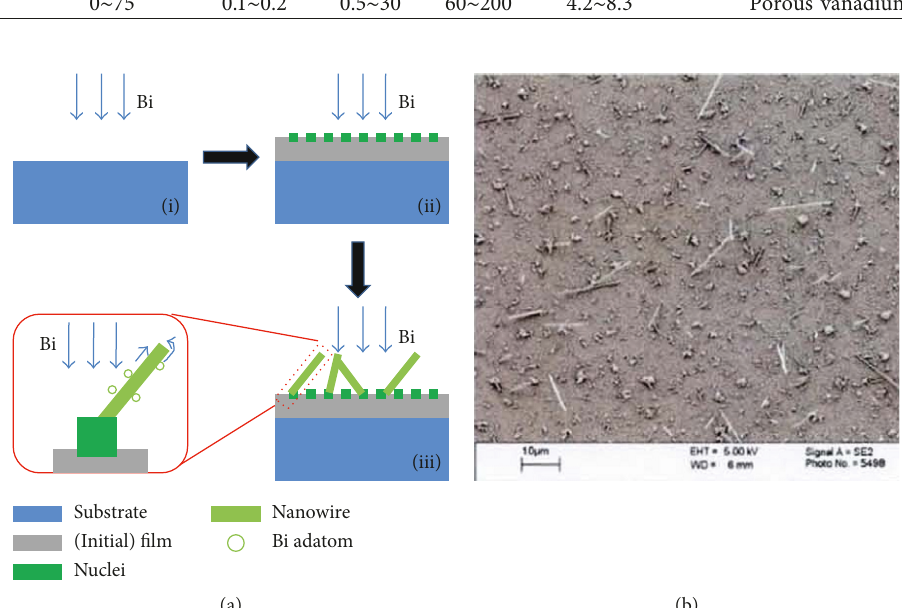
Figure 6: (a) Schematic representation of the tip-growth mode. (b) SEM image of Bi nanowires following the tip-growth mode. Reprinted from © Steven Antony Stanley, “The growth, structure and electrical properties of PVD deposited thin films and nanostructures of bismuth and antimony [D]” (2009), under CC by 2.5 license.